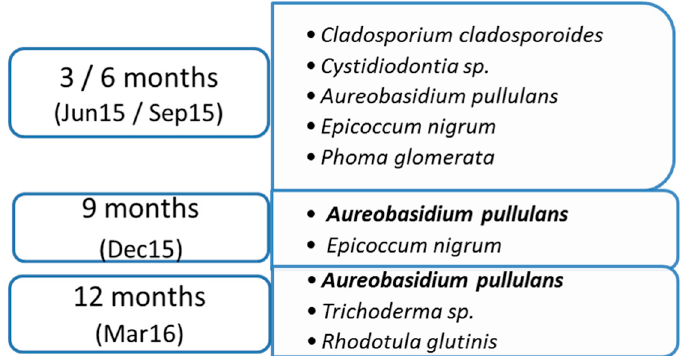
Figure 6. The main fungal species identified after 3, 6, 9, and 12 months of exposure on coated panels (south exposure at 45°). Species in bold were predominantly identified.